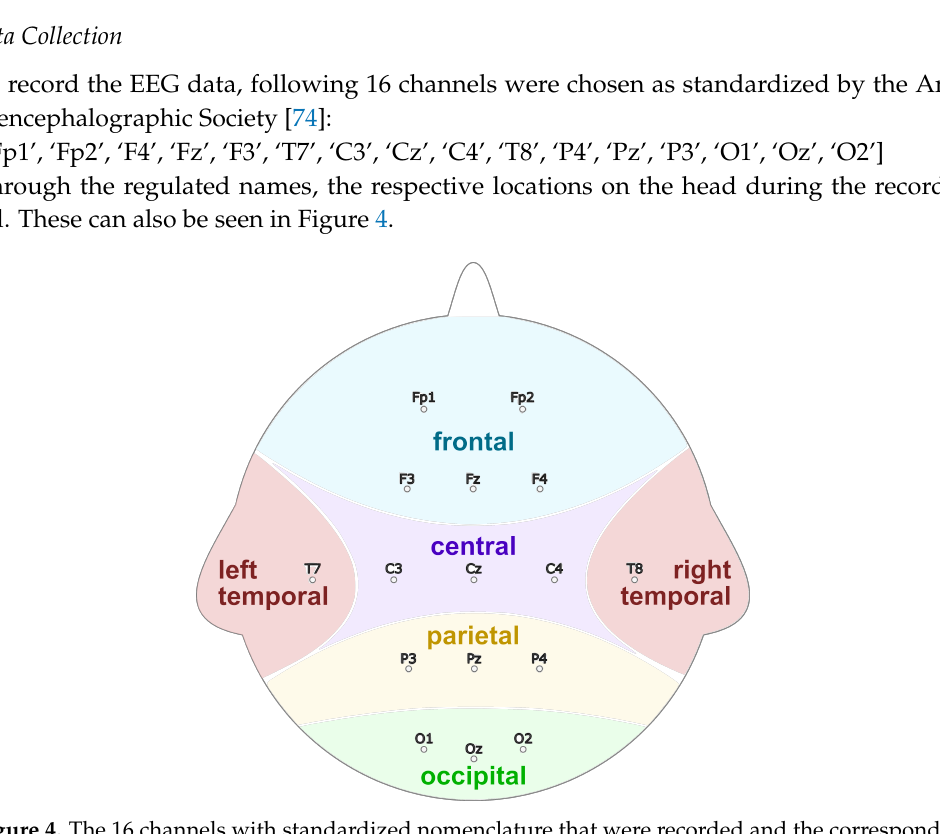
Figure 4. The 16 channels with standardized nomenclature that were recorded and the corresponding brain